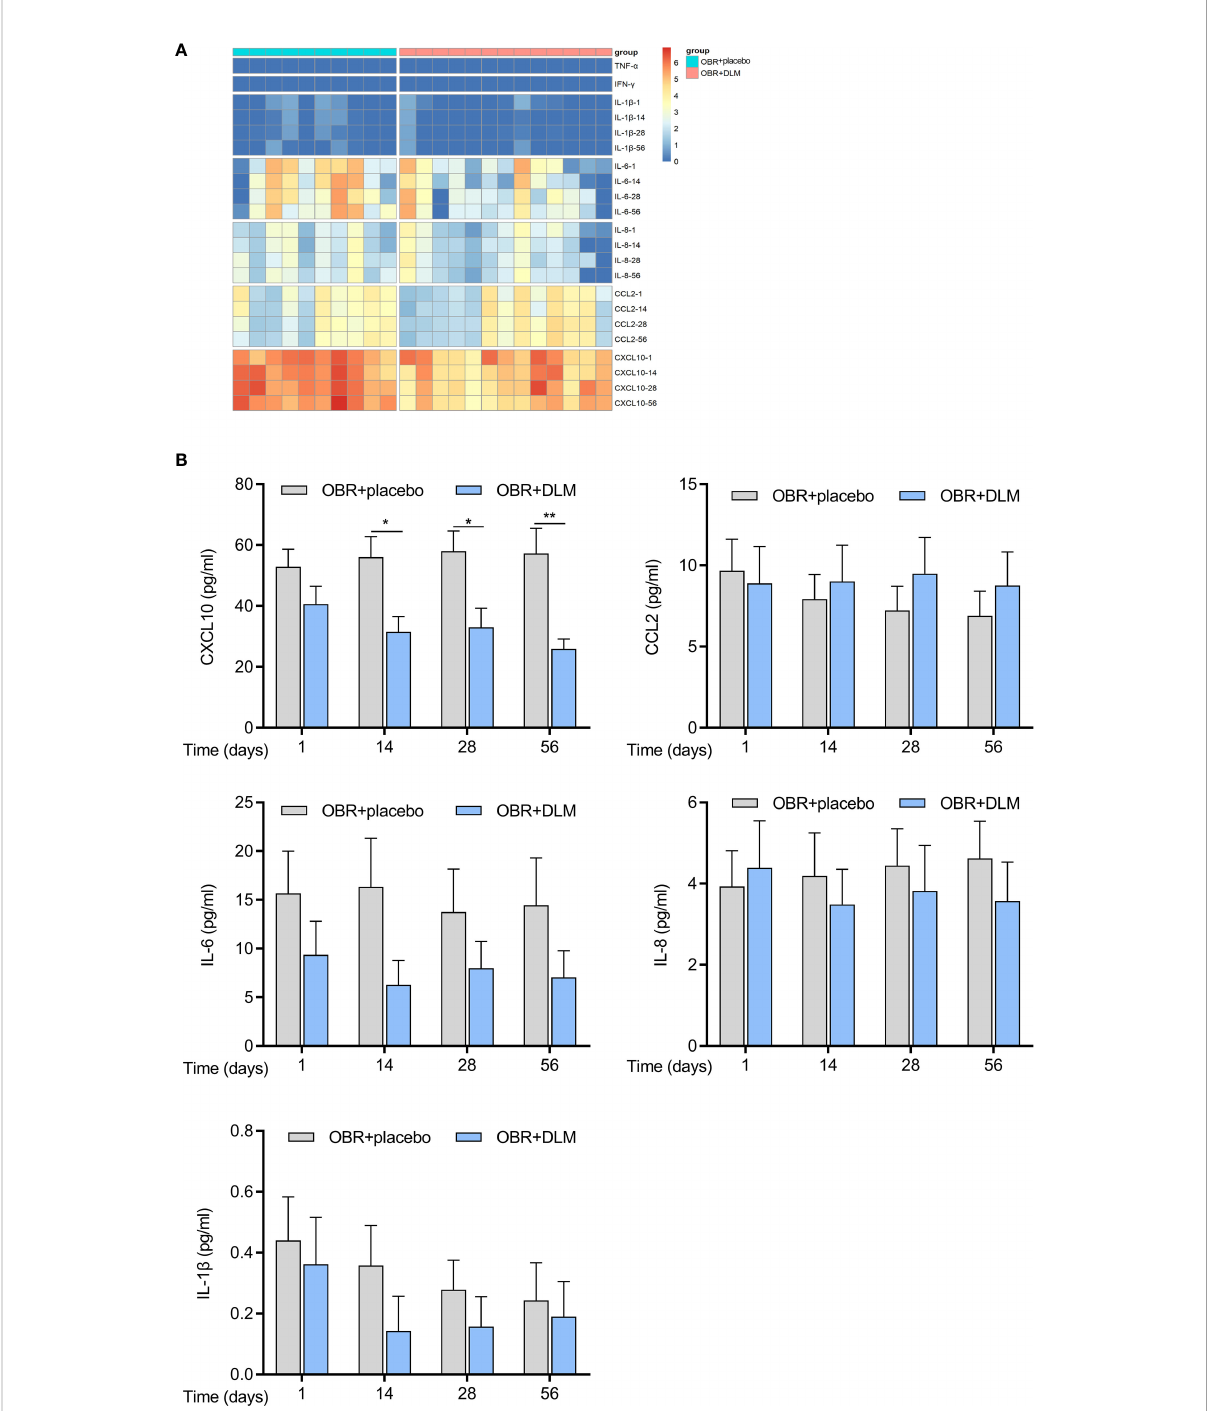
FIGURE 2 DLM modulates cytokine levels of in MDR-TB patients. Plasma from 23 individual donors were collected after treating with DLM (100 mg twice/ day) or not for 1, 14, 28, 56 days. (A) Heatmap showing differential expression of cytokine differentially expressed by MDR-TB patients. Each column corresponds to one donor, data were normalized to determine the log ratio with respect to the median expression of each cytokine. (B) The levels of cytokines in two group patients. Data are presented as mean ± SEM. * p <.05, ** p <.01 (two-way ANOVA). Results are representatives from at least three independent